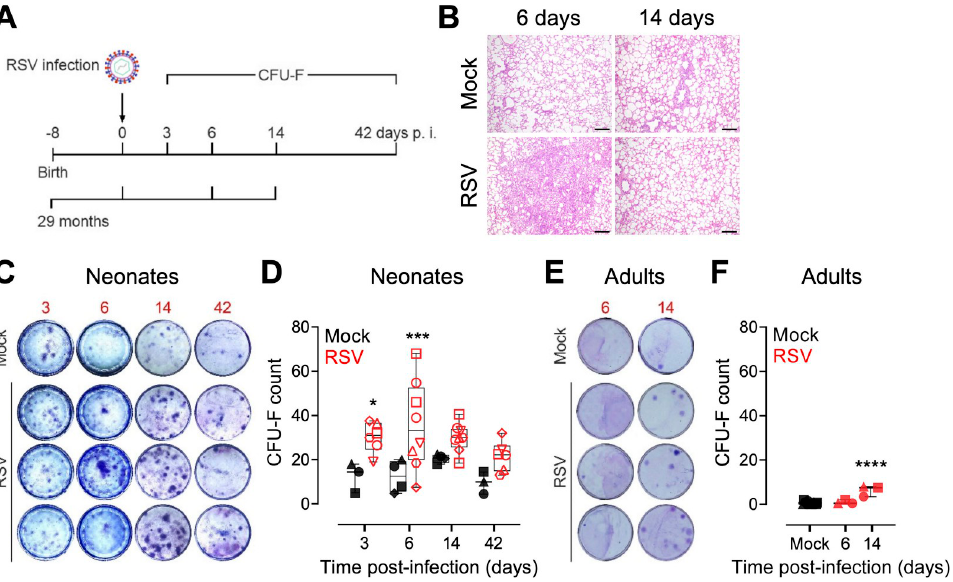
Fig 5. RSV infection leads to the expansion of the pulmonary MSC niche in vivo . (A) Newborn or adult (average age of 29 months) animals were trans-tracheal inoculated with 10 8 PFU per animal of the human strain RSV-A2 or PBS (mock). Newborns were euthanized 3, 6, 14, and 42 days p.i. and adults 6 and 14 days p.i. and lung tissue was harvested for CFU-F assay. Lung tissue of adults was harvested for histopathological evaluation (B) Representative H&E stained histopathological sections of the lung tissue from noninfected (mock) and RSV-infected adults at 6 and 14 days p.i. scale bar, 200 μ m. (C, E) Representative images of the CFU-F assay for mock control and RSV-infected neonates (C) and adults (E) 3 to 42 days p.i. and 6 and 14 days p.i., respectively. Each image represents an individual animal. (D, F) Quantification of the CFU-F assay for each neonate (D) and adult (F) animals, given as CFU-F count relative to 3.33X10 5 nucleated cells over time. Boxplots indicate the median value (centerline) and interquartile ranges (box edges), with whiskers extending to the lowest and the highest values. Each symbol represents an individual animal (neonates, per timepoint: mock, n = 3–4; RSV, n = 6–8; adults: mock, n = 14; RSV, n = 3 per timepoint). A one-way ANOVA and the Holm-Sydak post-hoc test was applied to compare differences between groups. � p < 0.05, ��� p < 0.001, ���� p <